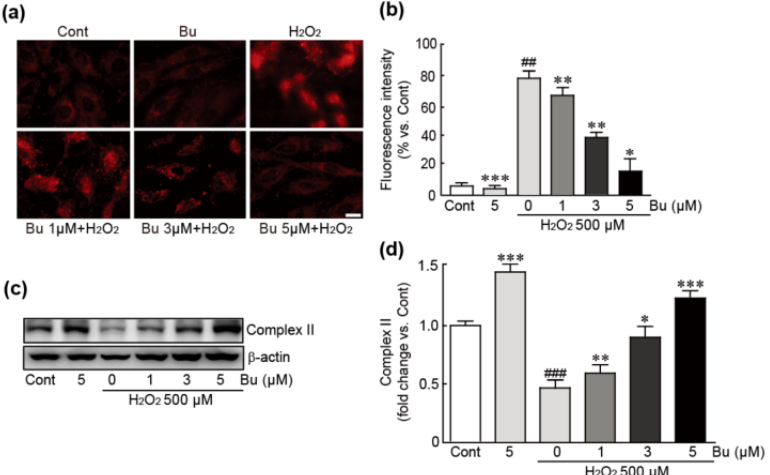
Figure 5. Butein attenuates mitochondrial ROS production and mitochondrial dysfunction in H 2 O 2 - treated H9c2 cardiomyoblasts. Mitochondrial ROS production was measured by MitoSox staining assay ( a ) and red fluorescence intensity ( b ) using cells treated with butein and/or H 2 O 2 . ( c ) Western blot analysis for the expression levels of mitochondrial complex II and β -actin (loading control) in butein-pretreated/H 2 O 2 -treated cells. ( d ) The band densities of the ratio of mitochondrial complex II protein were calculated with HD imaging software. The results are shown as the mean ± SEM in triplicate. ## p < 0.01 and ### p < 0.001 vs. control group. * p < 0.05, ** p < 0.01, and *** p < 0.001 vs. H 2 O 2 -only group. Cont; control, Bu; butein. Complex II; mitochondrial complex II. Scale bar, 100 µm. 3.6. Butein Inhibits Oxidative-Stress-Induced ER Stress in H9c2 Cardiomyoblasts To evaluate whether butein could affect the ER stress response, which is closely re- lated to oxidative stress, we performed Western blot analysis of proteins involved in ER eIF2 α proteins were activated because the phosphorylation of these proteins was upreg- ulated (Figure 6a–c). In addition, the expression levels of the ATF, CHOP, and GADD45 α proteins were significantly increased in H 2 O 2 -only-treated cells (Figure 6a,d–f). Other- wise, butein pretreatment significantly mitigated the upregulation of the expression levels of the aforementioned proteins. In particular, pretreatment with 5 µM butein inhibited the expression levels of these proteins to comparable levels as those in controls, indicating that butein exerts inhibitory effects on oxidative-stress-induced ER stress caused by H 2 O 2 in H9c2 cardiomyocytes.